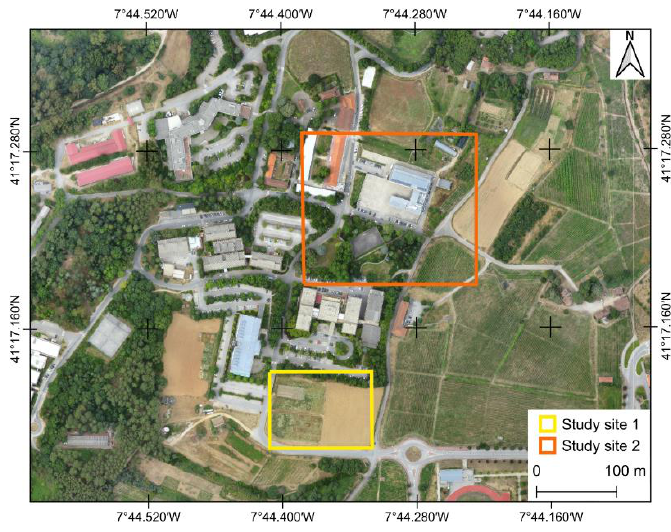
Figure 7. Location of the study sites.